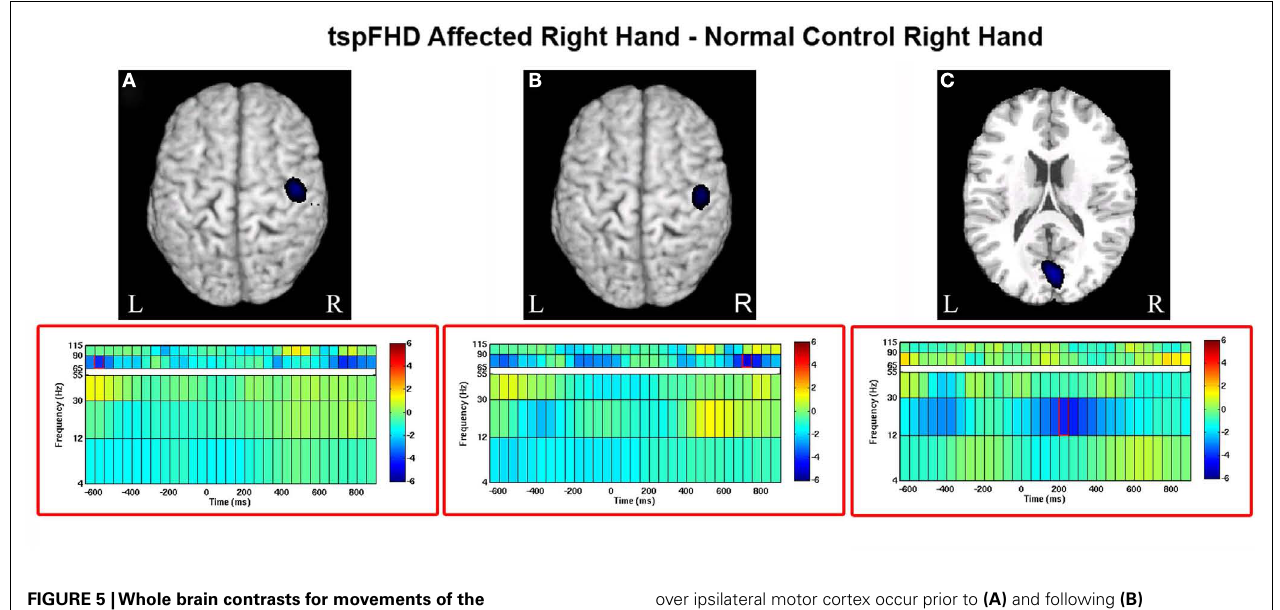
FIGURE 5 |Whole brain contrasts for movements of the affected hand. Group comparisons (tspFHD > healthy control) for the self-paced button press superimposed on MNI template brains. In tspFHD, decreases increases in high gamma (65–90Hz) activity